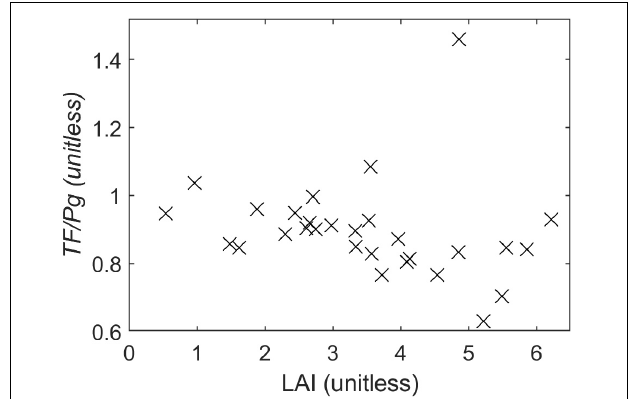
FIGURE 3 | The ratio of cumulative throughfall ( TF ) to cumulative gross precipitation ( P g ) by TF collector, regressed against LAI measured above each collector. Areas under denser canopy generally receive less